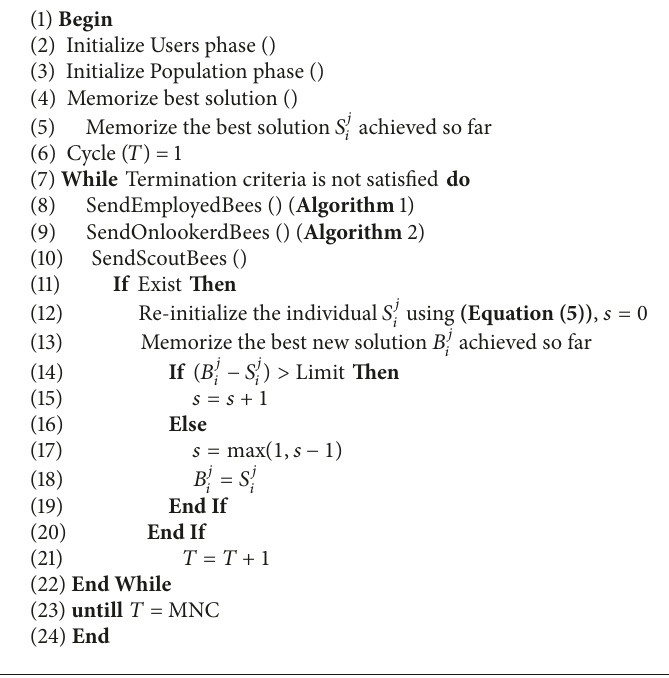
Algorithm 3: Pseudocode of